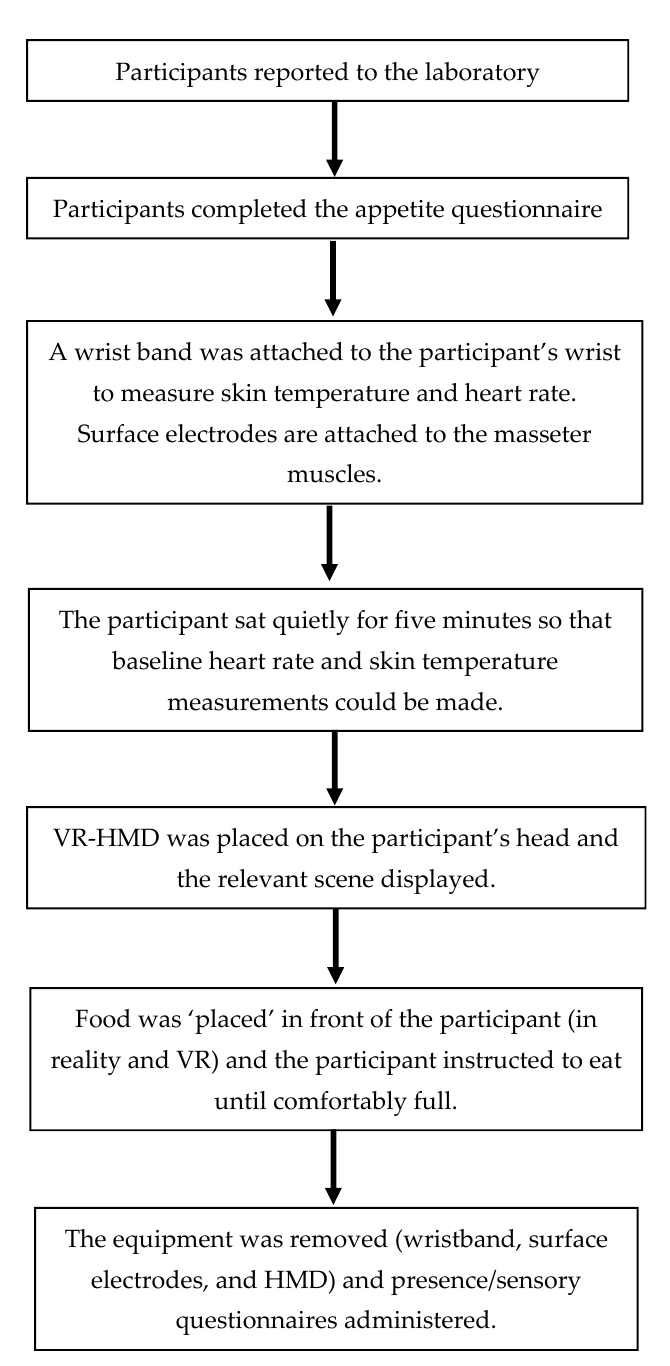
Figure 2. A simple schematic of the study procedure. Specific details of the procedures are provided in Section 2.1